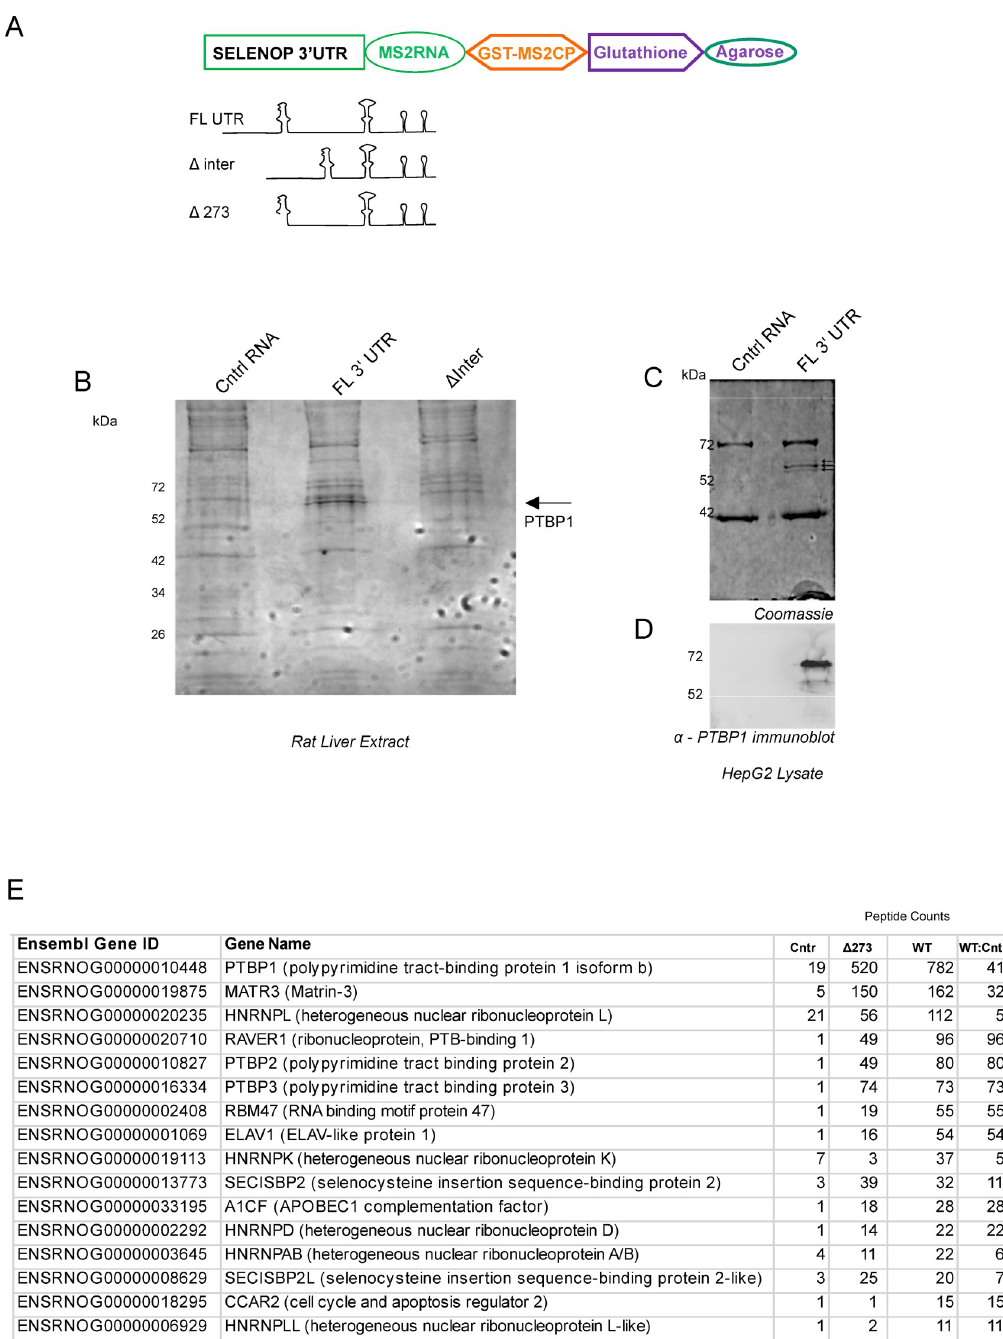
Fig 2. RNA affinity chromatography identifies PTBP1 and other SELENOP 3’ UTR binding proteins. A) Diagram of the components used for glutathione agarose affinity chromatography and RNA constructs used. B) SDS PAGE analysis of rat liver proteins eluted from a GST-MS2 column bound with either control RNA, SELENOP 3’ UTR (FL 3’ UTR), and the interSECIS deletion mutant ( Δ Inter). The gel was stained with Coomassie and the bands of interest excised from the gel for LC MS/MS analysis. C) SDS PAGE and D) immunoblot analysis of proteins eluted from RNA affinity experiments as described in A) except that HepG2 lysate was used. The immunoblot was probed with anti-PTBP1 antibody. E) Peptide counts and cognate genes that were identified by LC MS/MS MudPIT analysis after RNA chromatography using control RNA (Cntl), wild-type SELENOP 3’ UTR (WT) and an RNA lacking the first 273 nt of the SELENOP 3’ UTR ( Δ 273). The ratio of peptide counts from WT UTR versus control RNA is shown (WT:Cntr). The genes shown here correspond to those with a ratio of 5 or above and a peptide count of 10 or above.